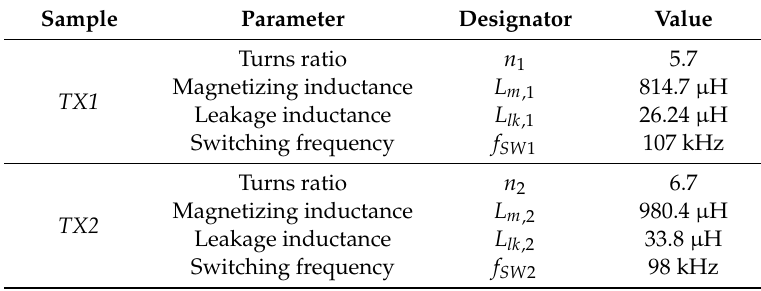
Table 2. Specifications of the alternative isolation transformers used in the